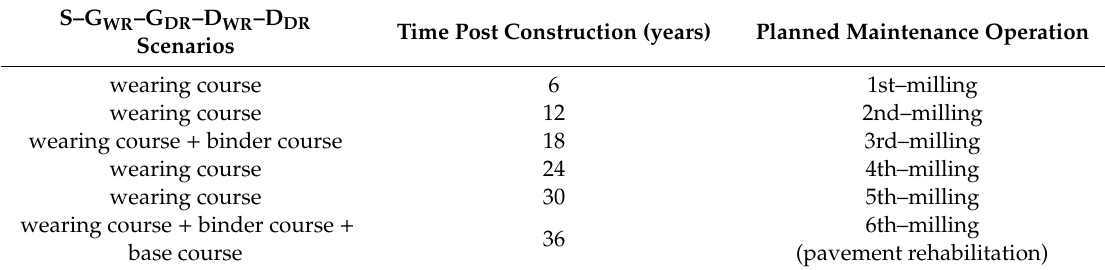
Table 5. Maintenance and planned operations of standard, gap-graded, and dense-graded scenarios.